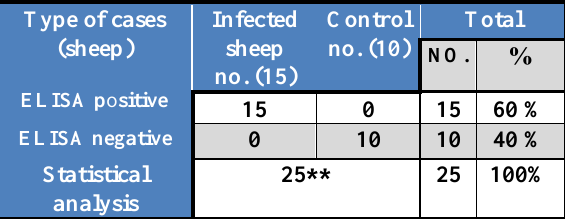
Significant differences (P≤ 0.01).** Table, 2: ELISA result for sheep serum samples.